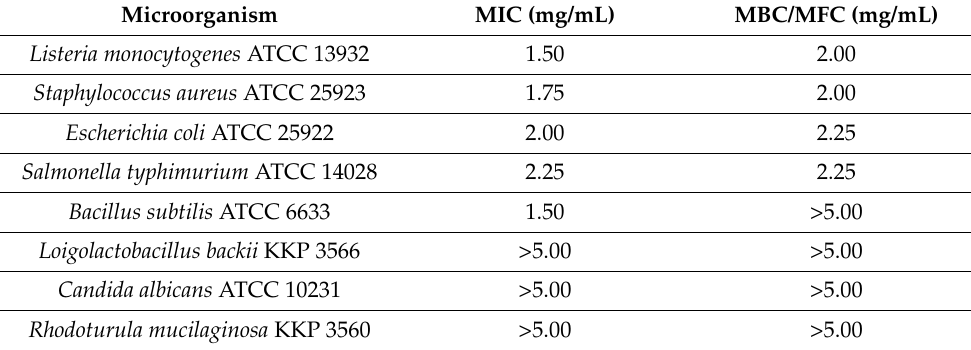
Table 8. The effect of mandelic acid on the maximum growth rate (µ max ) of the tested strains—Gom- pertz analysis.